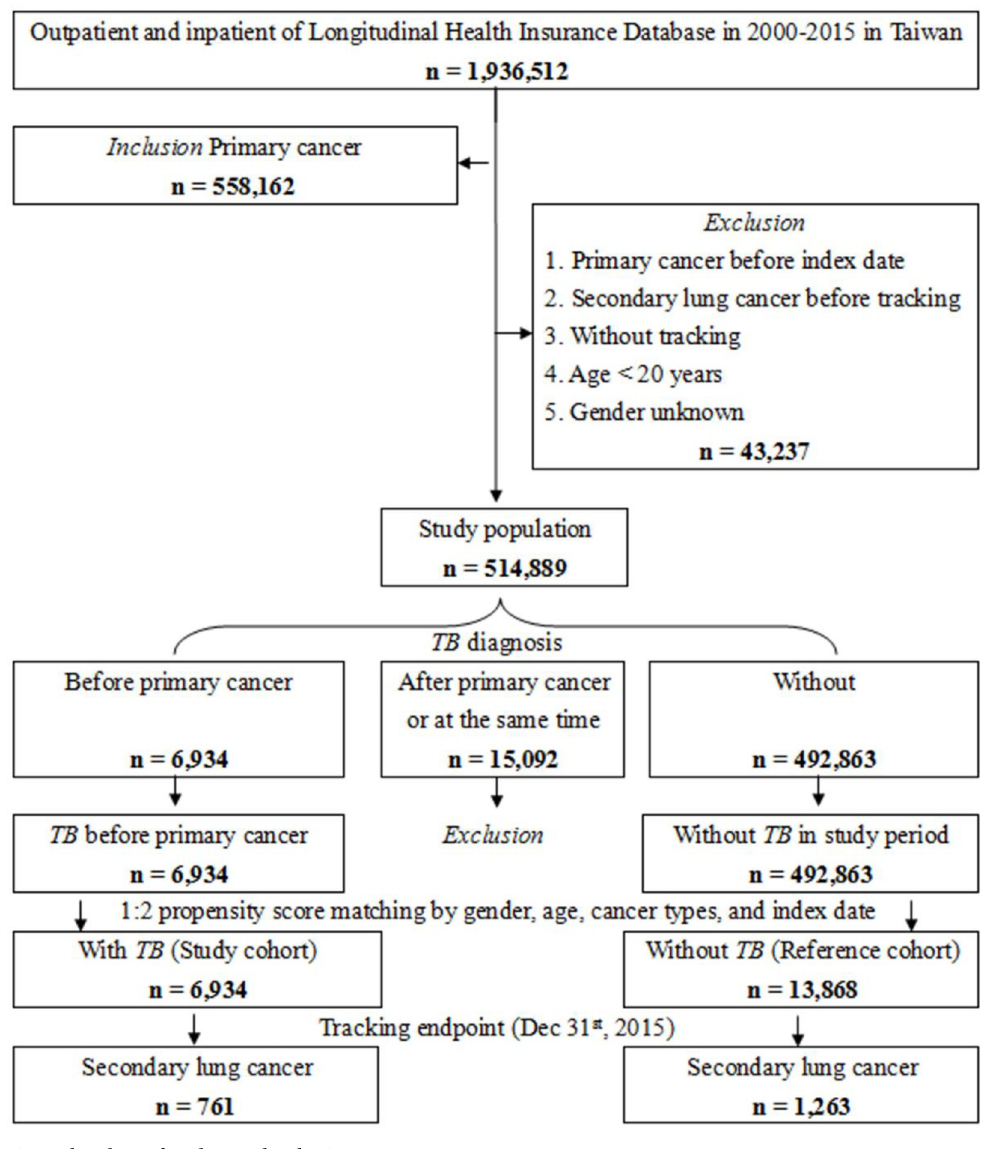
Fig 1. Flowchart of study sample